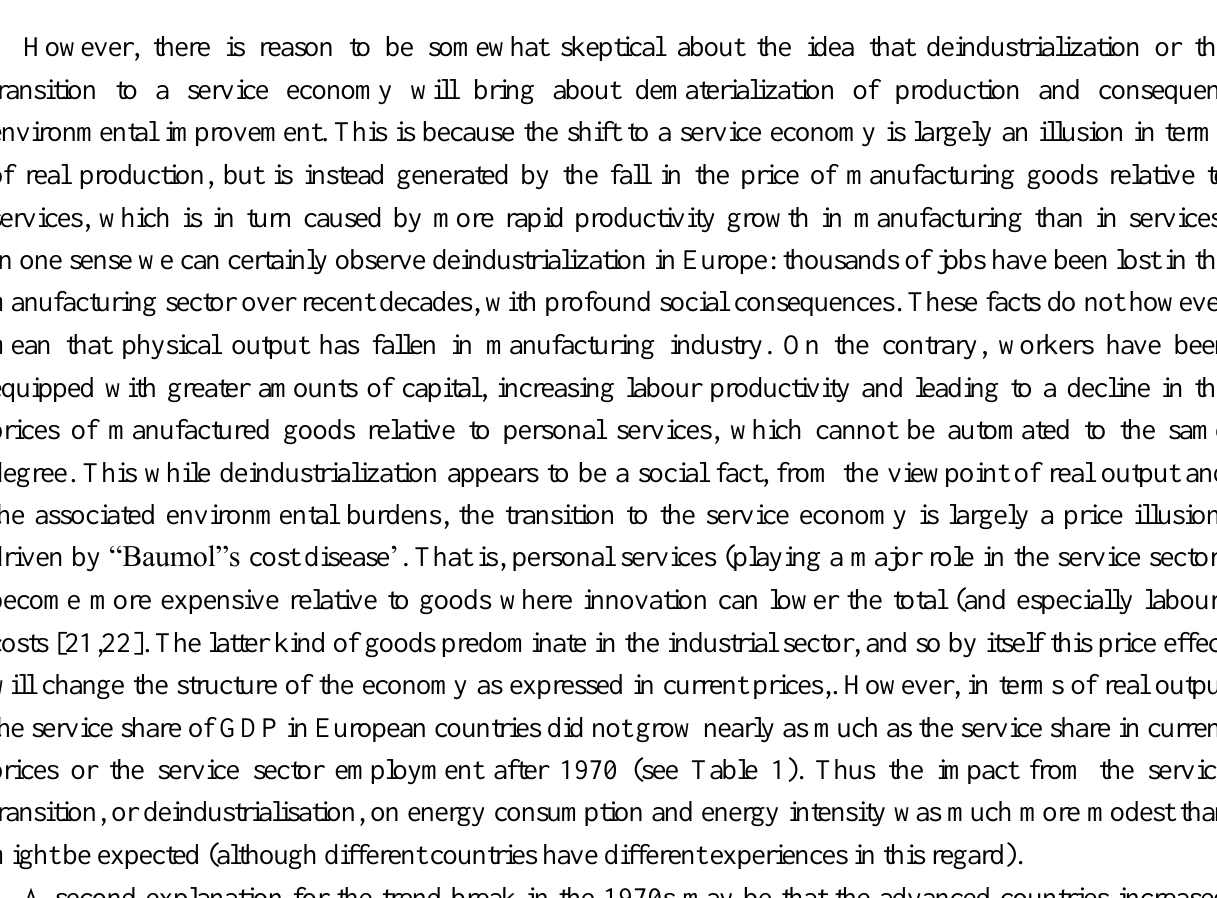
Figure 4. The role of structural change for energy intensity development. Source: